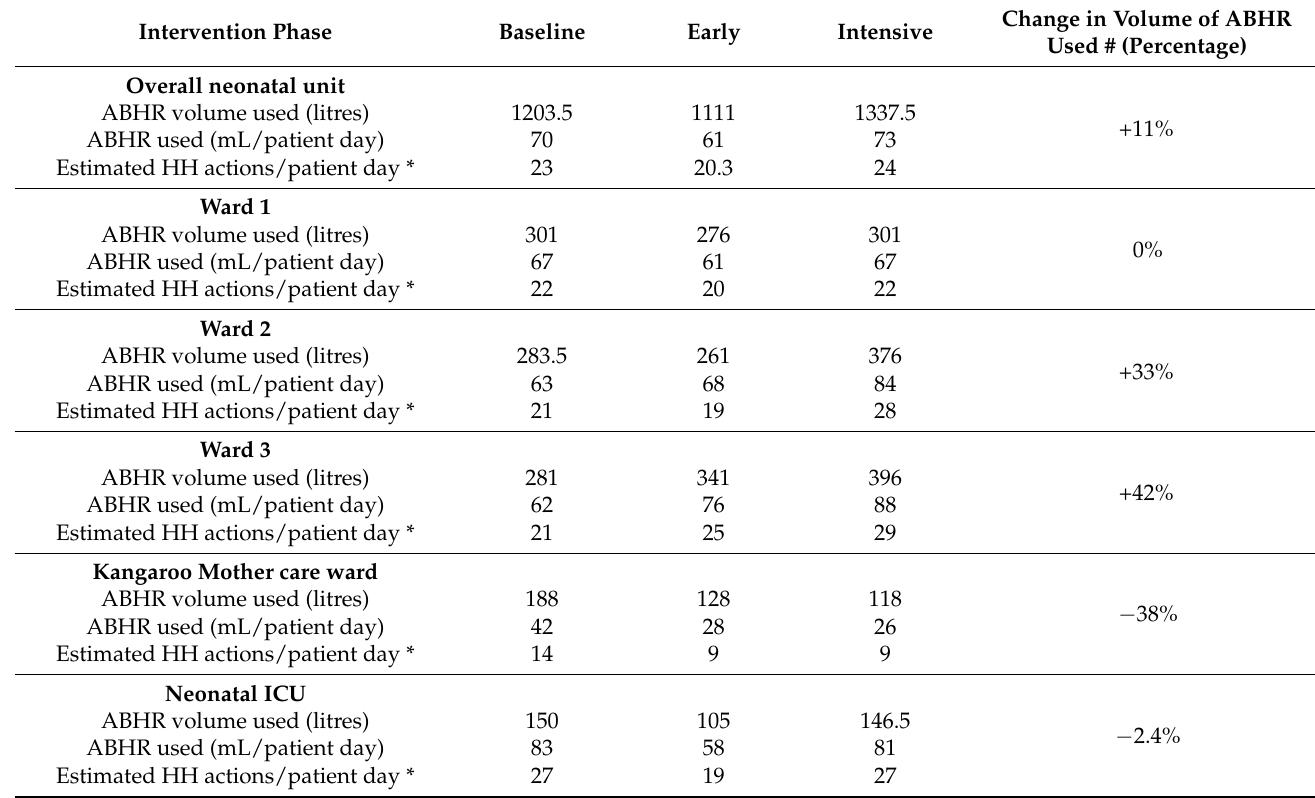
Table 2. Changes in alcohol-based handrub usage during the SafeHANDS intervention.